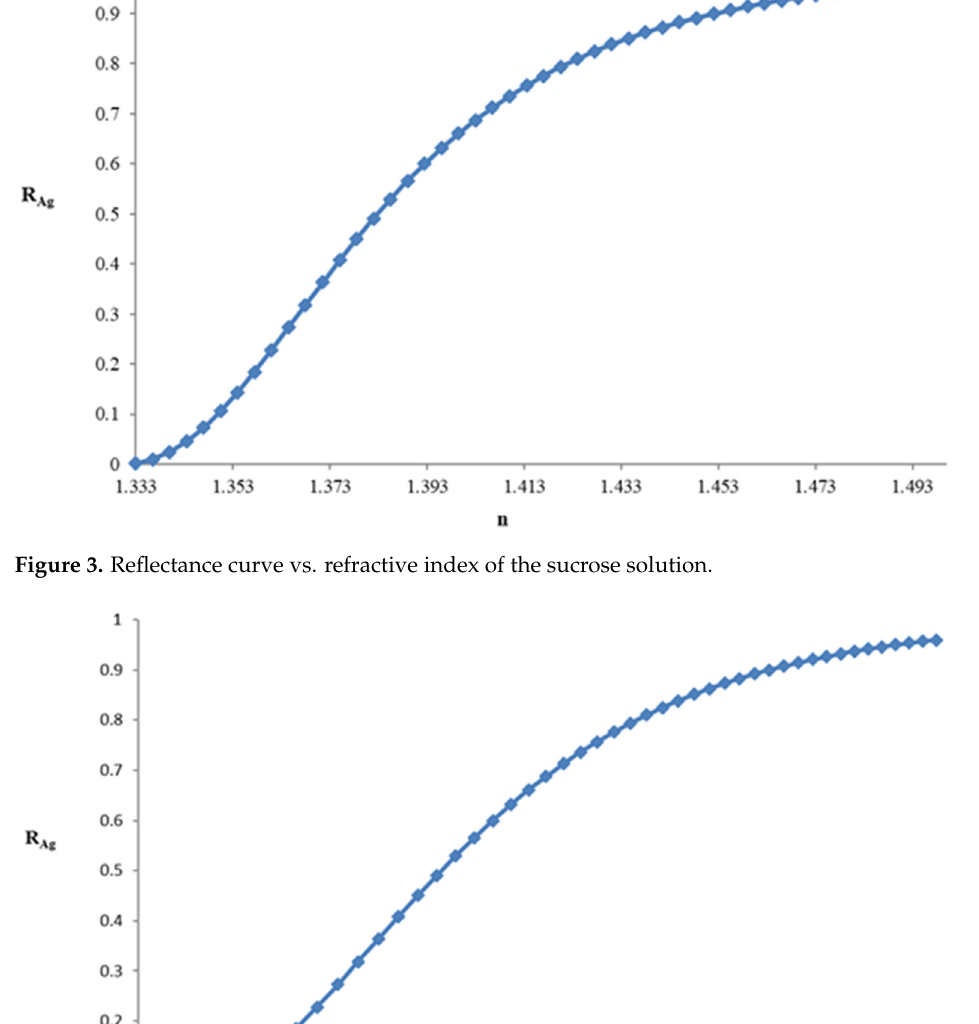
Figure 2. Reflectance curves as a function of the angle of incidence of the light in the prism for the range of refractive index values.